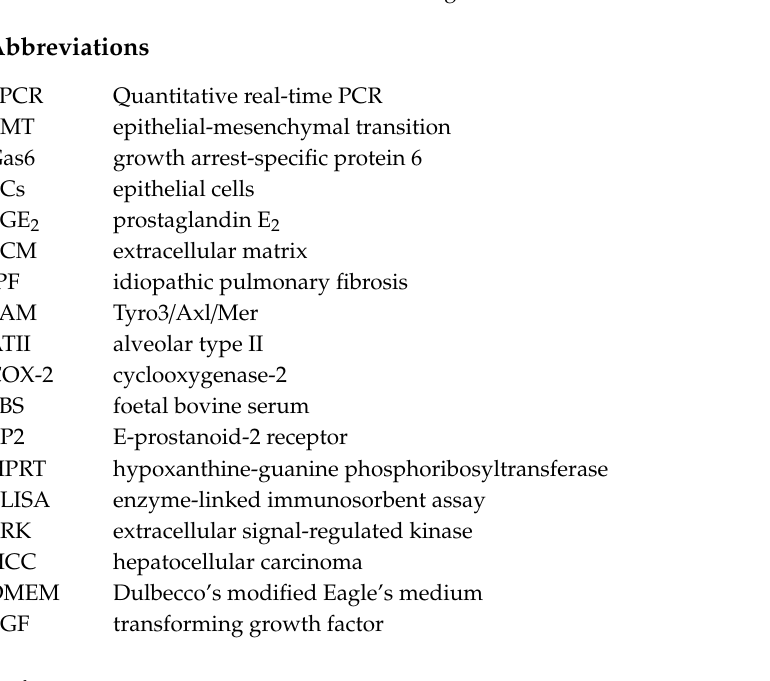
Figure S1: E ff ect of Gas6 on TGF- β 1-induced epithelial-mesenchymal transition (EMT) in lung and kidney epithelial cells. Figure S2: E ff ect of Gas6 pretreatment on epithelial-mesenchymal transition (EMT)-regulating transcription factor expression and TGF- β 1 signaling in epithelial cells. Figure S3: Cyclooxygenase (COX)-2 signaling is required for Gas6-induced inhibition of epithelial-mesenchymal transition (EMT) in LA-4 epithelial cells. Figure S4: Antagonists of prostaglandin (PG)E 2 and PGD 2 receptors reverse Gas6-induced epithelial-mesenchymal transition (EMT) inhibition in LA-4 epithelial cells. Figure S5: Inhibition of Axl or Mer signaling reverses suppression of epithelial-mesenchymal transition (EMT) in LA-4 epithelial cells by Gas6. Figure S6: Gas6 inhibits on TGF- β 1-induced migration and invasion through prostaglandin (PG)E 2 and PGD 2